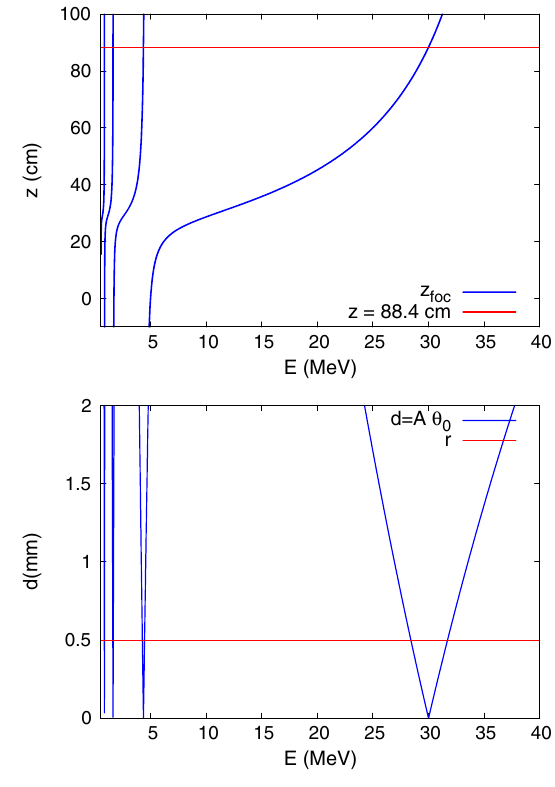
FIG. 12. Upper frame: Plot of the focus as a function of the energy compared with the focus for E ¼ 30 MeV . Lower from the z axis at the frame: comparison of the distance d ¼ A(cid:7) 0 point z ¼ 88 : 4 with the collimator radius r ¼ 0 : 5 mm when the ¼ y 0 ¼ 0 : 01 energy varies and x 0 0 0